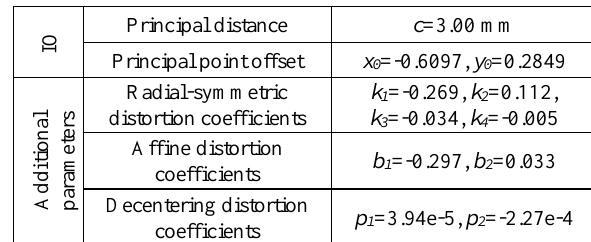
Figure 3. Camera network for calibration of each GoPro 4 Black ® cameras.